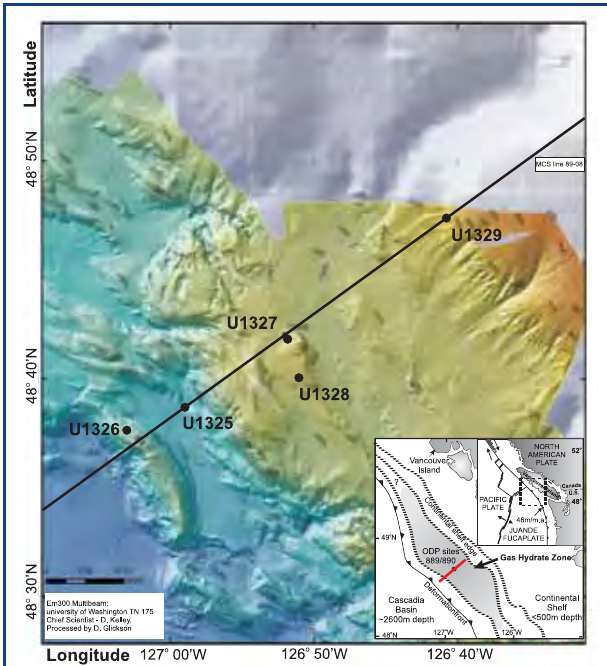
Figure 1. Multibeam bathymetry map along transect across accre- tionary prism offshore Vancouver Island established during IODP Expedition 311 (courtesy of D. Kelly and J. Delaney, University of Washington and C. Barnes, C. Katnick, NEPTUNE Canada, Univer- sity of Victoria). Inset: General tectonic location of drilling transect near previous ODP Sites 889 and 890. BSR is present on ~50% of mid-continental slope (shaded area, from Hyndman et al.,